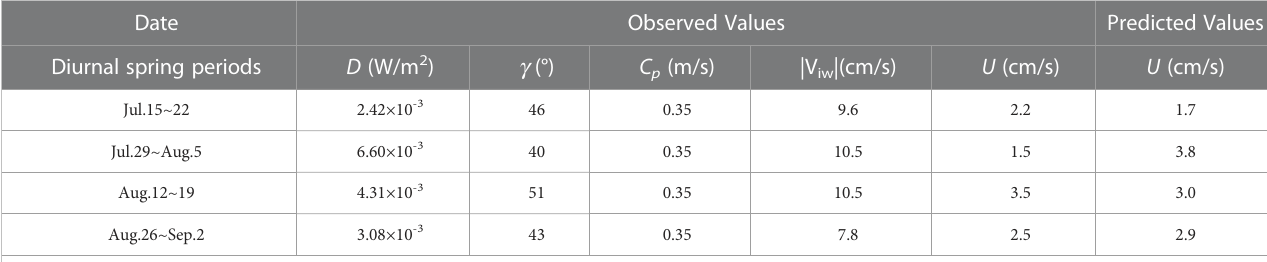
TABLE 1 The along-slope bottom velocity U is estimated by equation (11) at four diurnal springs. Date Observed Values Predicted Values Diurnal spring